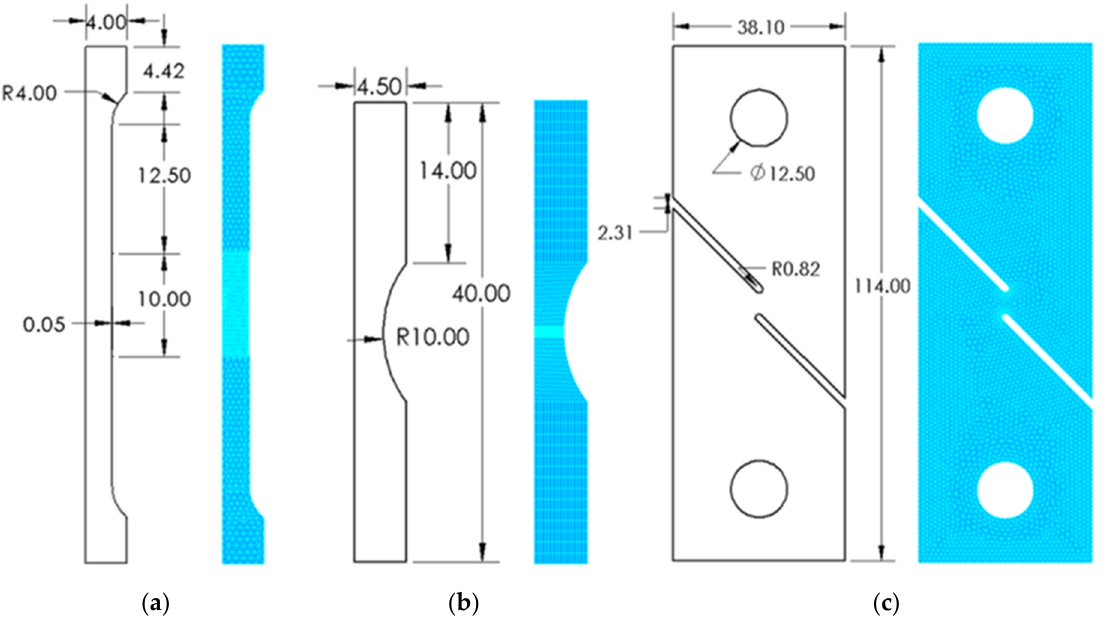
Figure 4. Technical drawing and the mesh of ( a ) round bar, ( b ) round notched bar, and ( c ) pure shear sample. All dimensions are in mm.